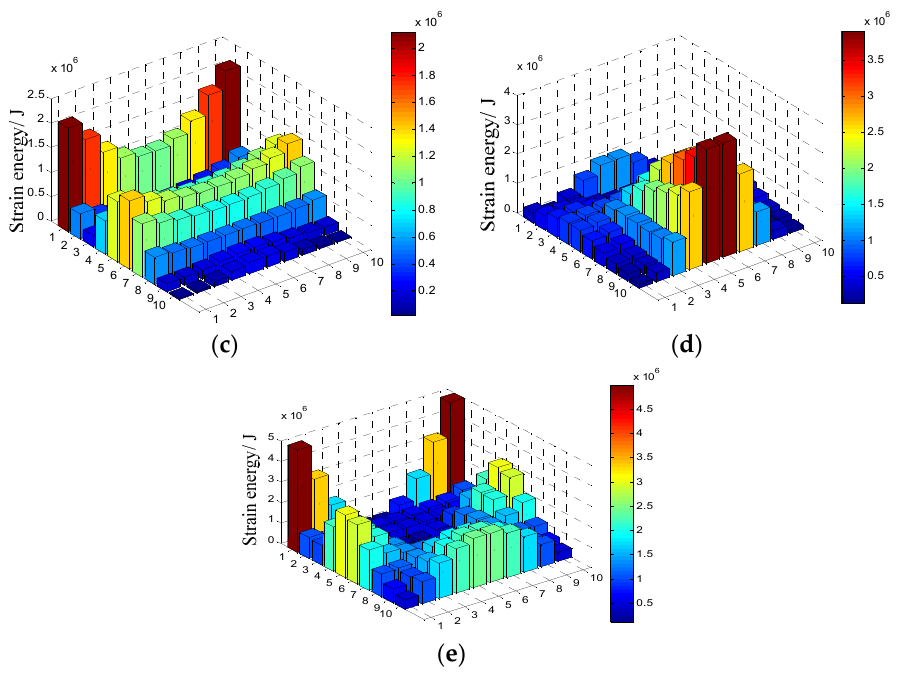
Figure 7. The modal strain energy distribution of the first five orders of cantilever thin plate: ( a ) The first order; ( b ) the second order; ( c ) the third order; ( d ) the forth order; ( e ) the fifth order.